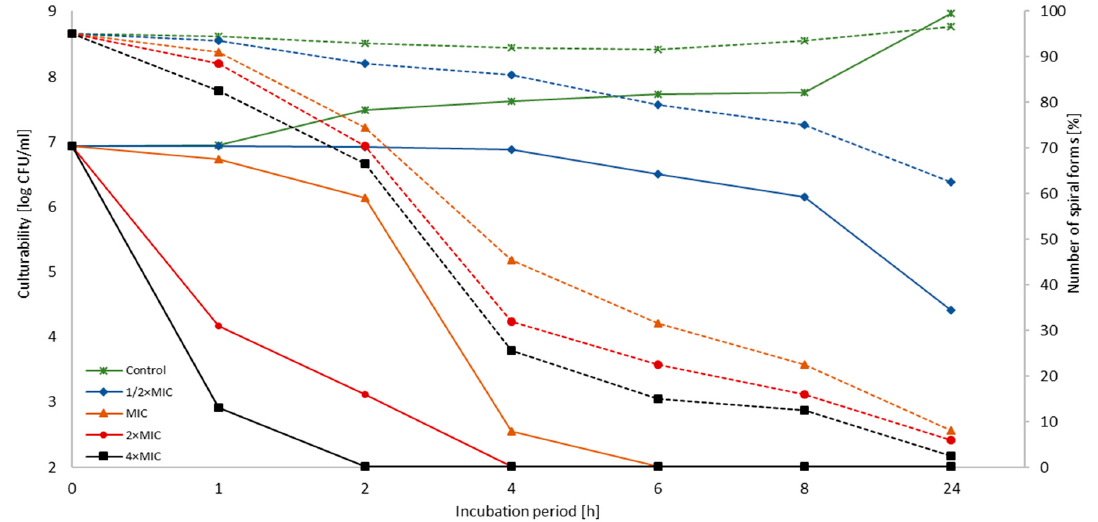
Figure 1. The effect of 3-Bromopyruvate (3-BP) on the culturability and morphology of H. pylori Tx30a during the incubation period. The number of spiral forms is marked with dotted lines, while the culturability is indicated by continuous lines.